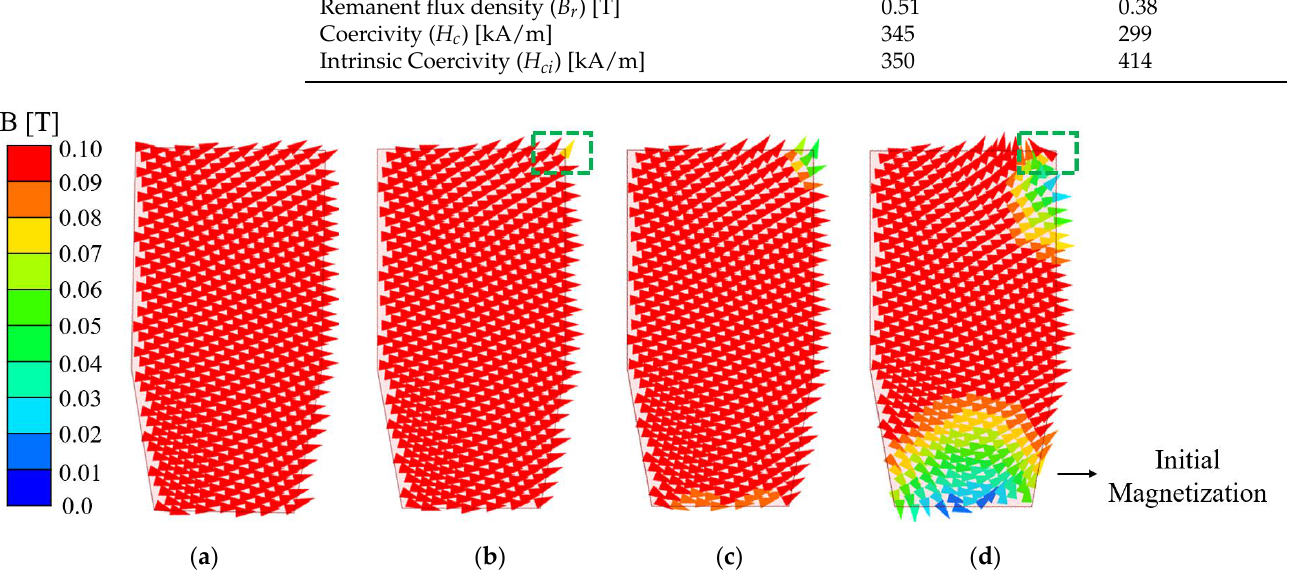
Figure 17. Flux density ( B ) distribution of 6Φ -SS-FSCW-Fer-SIPMSM at − 40 °C when the motor current was ( a ) 2.6× and ( b ) 2.8× rated current, and 80 °C when the motor current was ( c ) 2.6× and ( d ) 3.4× rated current.